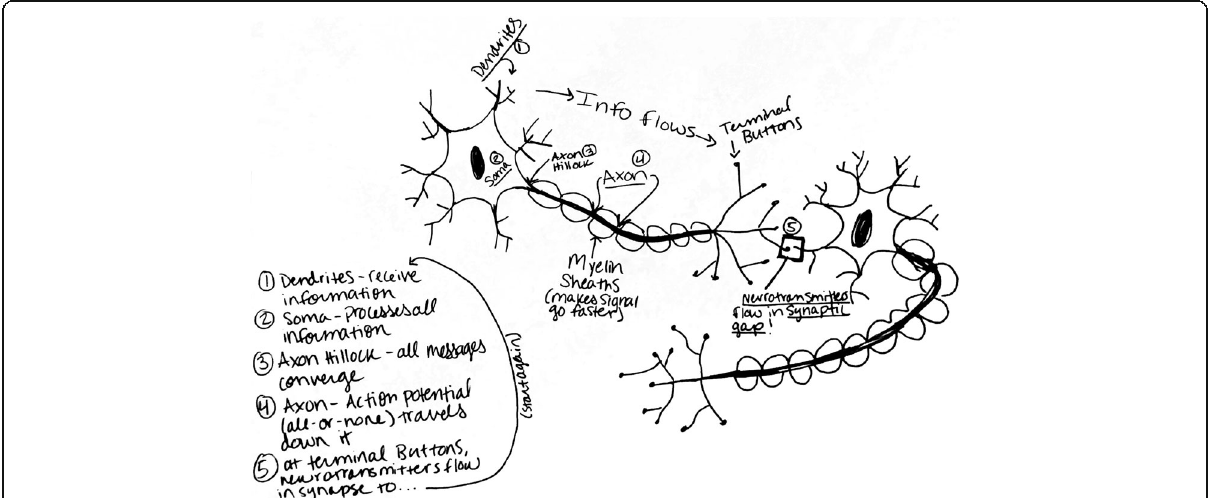
Fig. 6 Example of how to enhance learning through use of a visual example. Students might view this visual representation of neural communications with the words provided, or they could draw a similar visual representation themselves. Copyright note: this figure was produced by the authors